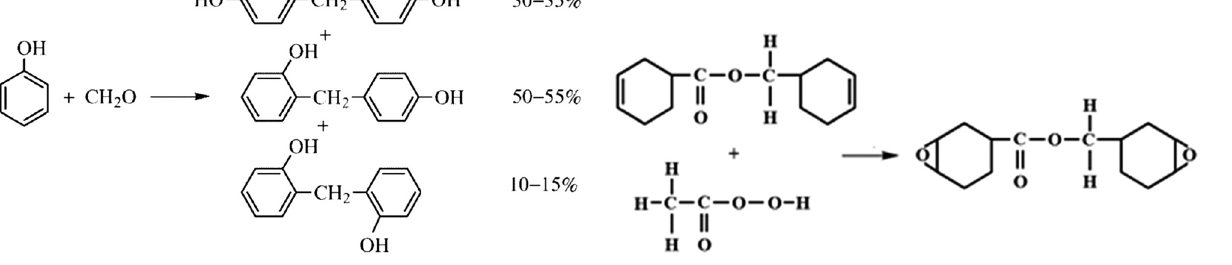
Figure 2: Formation reaction of bisphenol F from formaldehyde and phenol [ 20 ] .